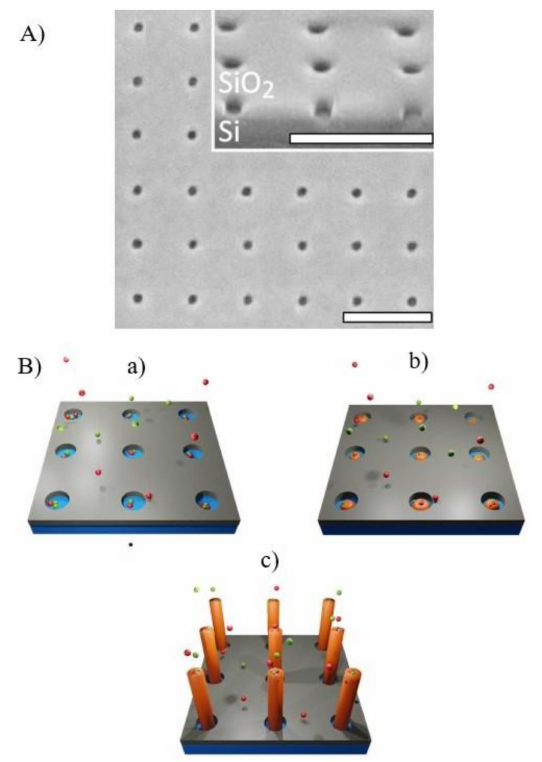
Figure 6. ( A ) Scanning electron micrograph of a nanoscale hole pattern realized on a 20 nm-thick thermally grown SiO 2 layer, used as a mask template for nanowire selective area growth (Reprinted with permission of Ref. [149]). The pattern was realized by means of electron beam lithography followed by reactive-ion etching. The holes have a diameter of 20 nm and spacing of 125 nm and are arranged in a square lattice (the inset shows a tilted view of the pattern). The scale bar is 200 nm for all micrographs. ( B ) Pictorial representation of the selective area growth process: (a) the substrate, covered with the thin dielectric mask template, is exposed to the precursor gases; (b) the semiconductor material only grows selectively on the exposed regions of the substrate; (c) final selective area grown